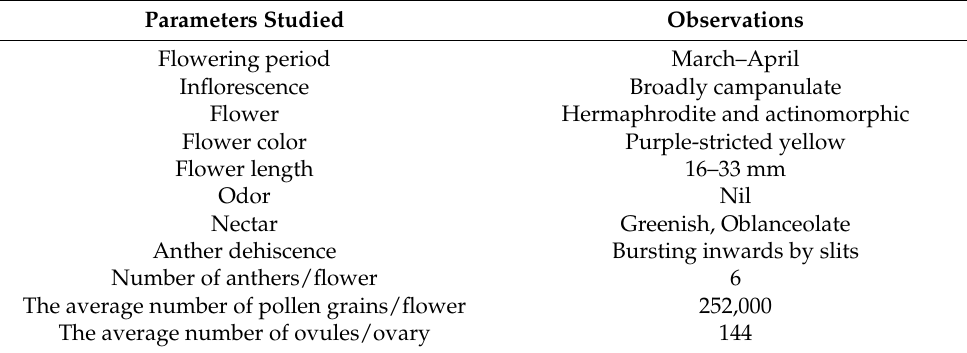
Figure 2. Floral features and reproductive phenology of F. michailovskyi . ( a ). F. michailovskyi, ( b ). nectary sac, ( c ). anthers, ( d ). pistil, ( e ). stigma receptivity, ( f ). pollen grains, ( g ). seed capsule (arrows represent the location of the six seed capsules), ( h ). seed set, ( i ). pollinator ( Apis mellifera ). (original photo by M. Aslay). Table 1. Some identified floral features of F. michailovskyi